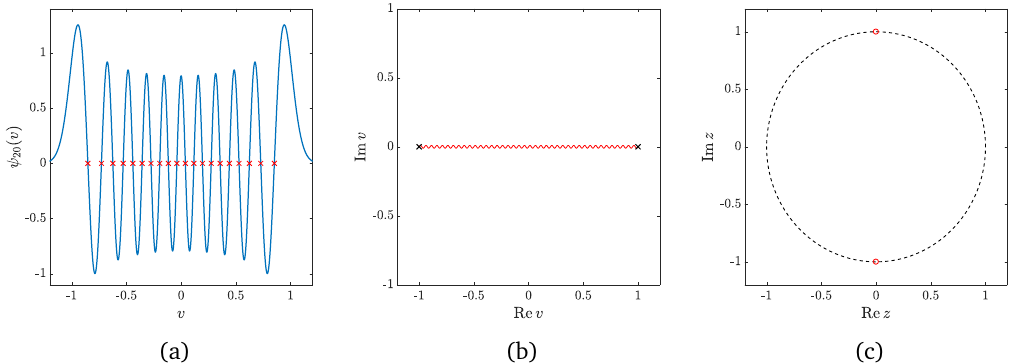
( v ) with mode number 20 and rescaled Figure 1: (a) Normalised wavefunction ψ (cid:112) 20 coordinate v = u / 40. Its zeros are marked by red crosses. At large mode numbers, zeros of wavefunctions approach each other and eventually condense. The result- ing condensate can be viewed as a square-root branch cut of a spectral curve, cf. Eq. (2.21). Classical spectral curve of the harmonic oscillator in the v -plane (b) and z -plane (c). The branch cut in (b) gets mapped into two punctures of the Riemann surface. The dashed line indicates the motion of dynamical variable z (cid:63)